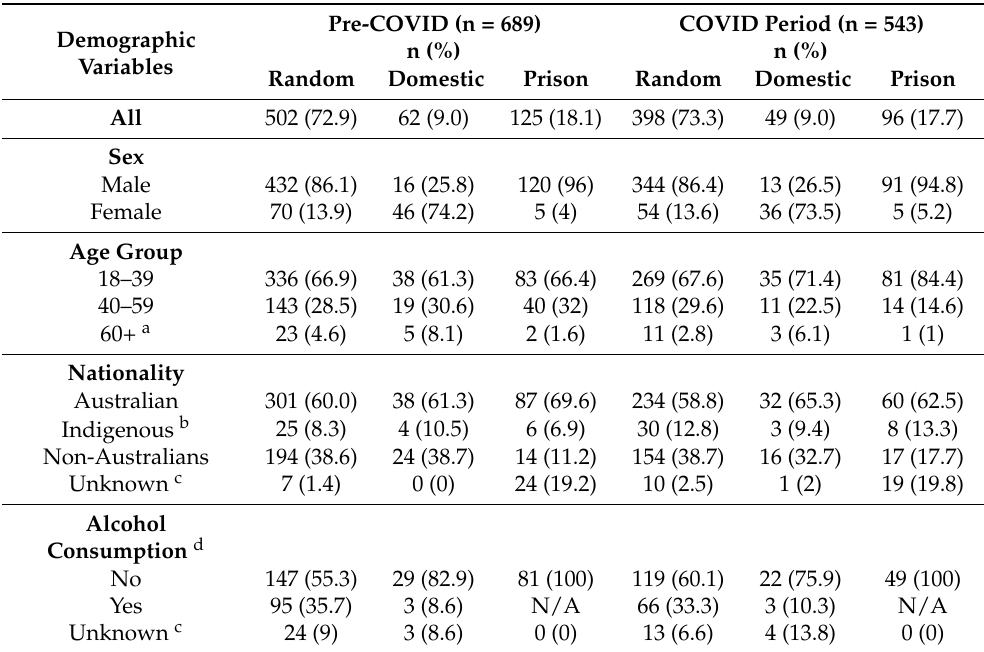
Table 2. Demographic characteristics between COVID periods across all assault subgroups.